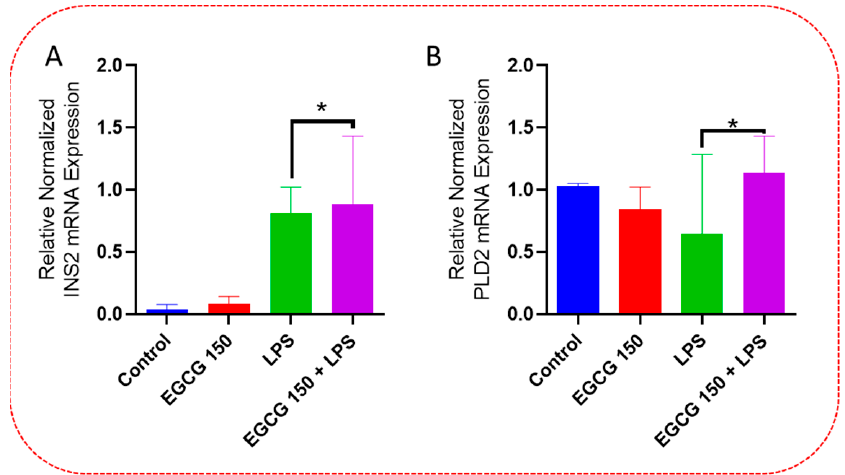
Figure 12. EGCG upregulated insulin signaling-related mTOR genes. PCR array experimentation indicated that EGCG 150 µM coupled with LPS (1 µg/mL) heightened mRNA expression of INS2 ( A ) and PLD2 ( B ) compared to LPS. Values represent the mean ± SD, * p ≤ 0.05 vs. LPS.